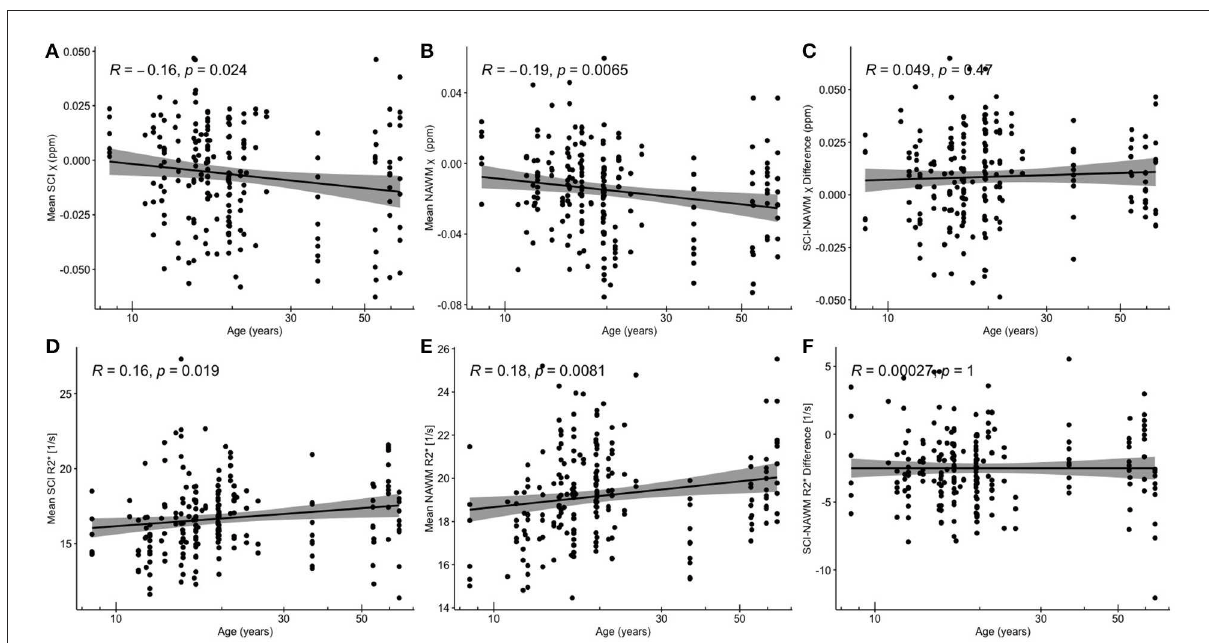
FIGURE5 Correlations between SCI and NAWM χ and R * 2 and age. (A) Mean silent cerebral infarct (SCI) susceptibility ( χ ) (B) mean normal appearing white matter (NAWM) χ (C) SCI-NAWM χ difference (D) mean SCI R * 2 (E) mean NAWM R2* (F) mean SCI-NAWM R2* difference as a function of age plotted on a logarithmic scale. SCI were segmented using the FLAIR-based SIT trial definition.